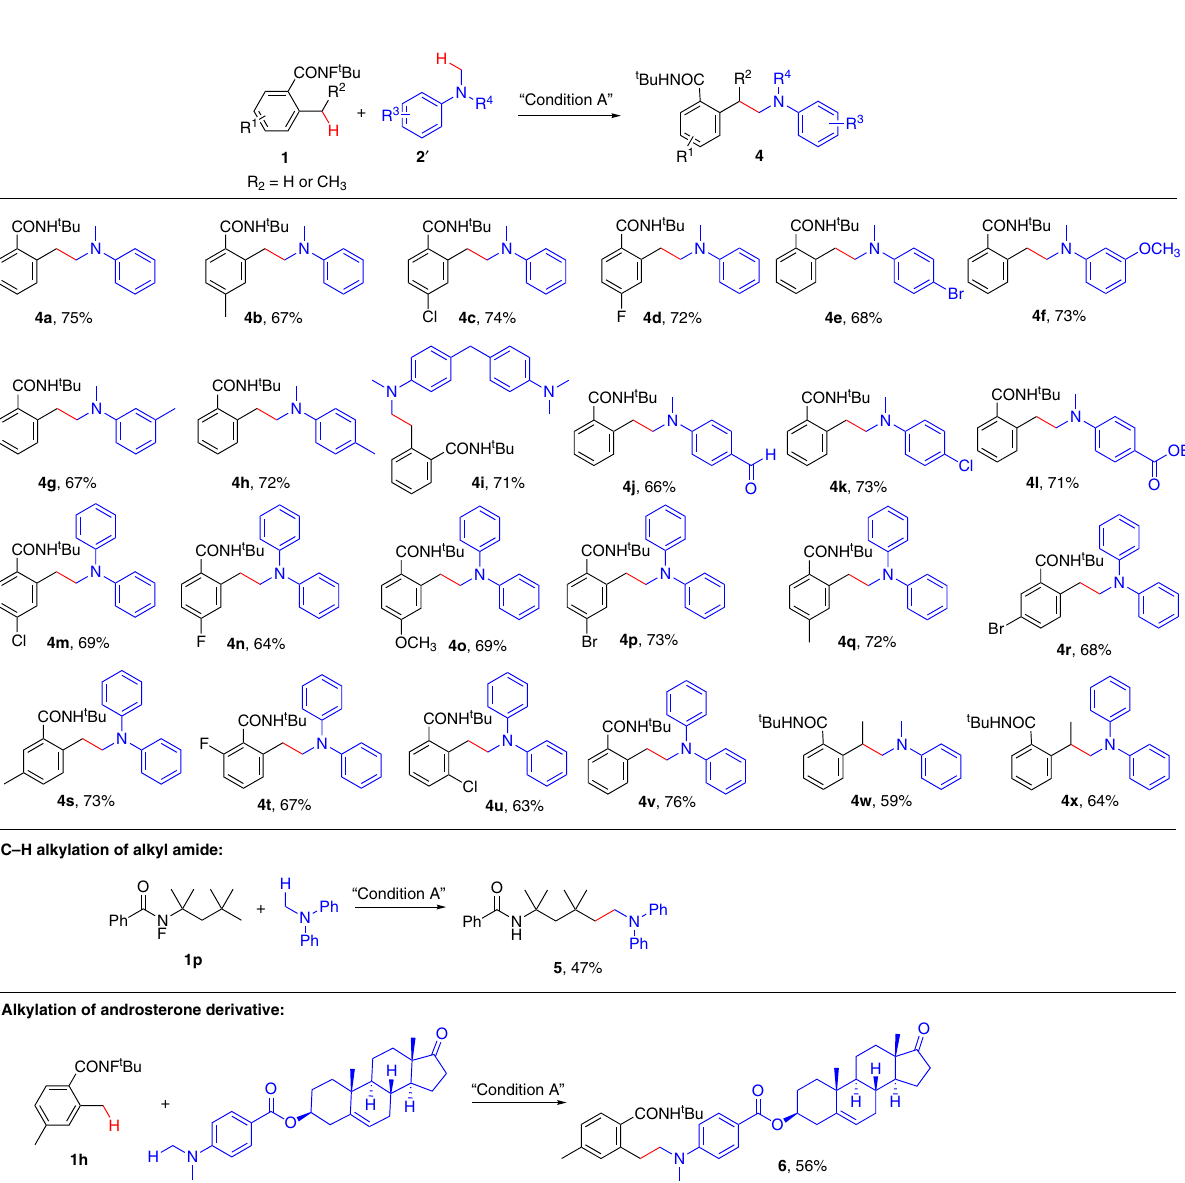
Fig. 6, under the standard reaction conditions, 1o and 1p were